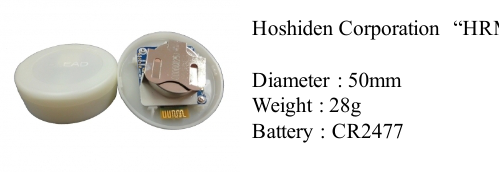
Figure 2. Installed BLE device